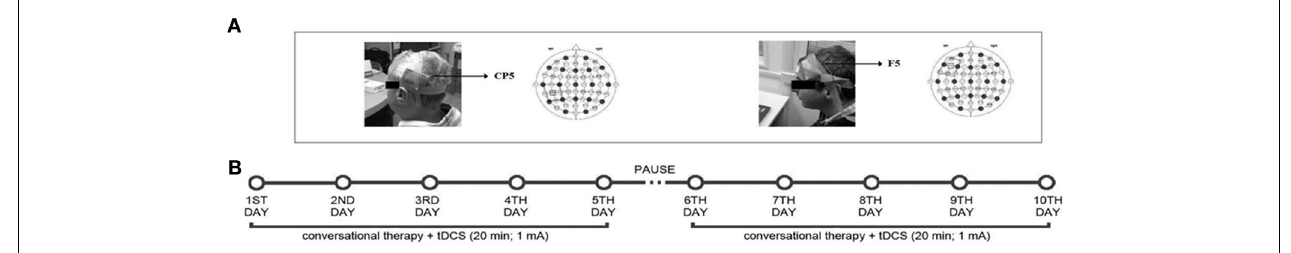
FIGURE 2 | LocalizationofthetDCSarea(A)andoverviewofstudydesign (B): one video-clip was used for the anodic Broca’s stimulation, one for the anodic Wernicke’sstimulation and a third one for the sham Broca’s or